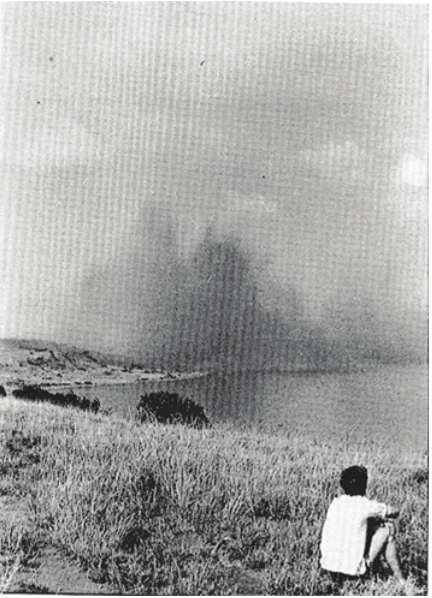
Figure 1: A swarm of chaoborid midges over Lake George, Uganda (photo by L.